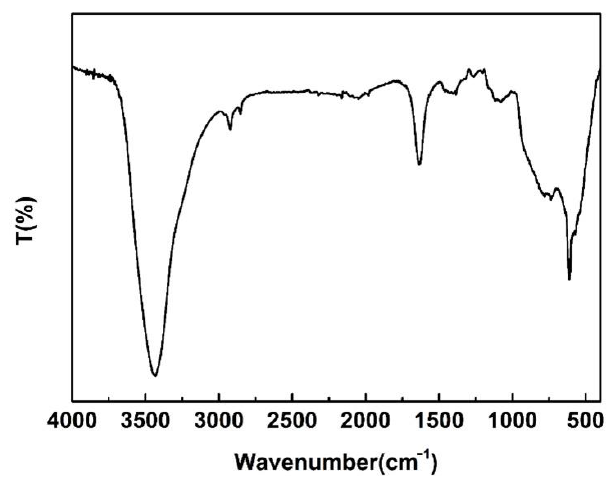
Figure 2. FTIR spectrum of A17H6.